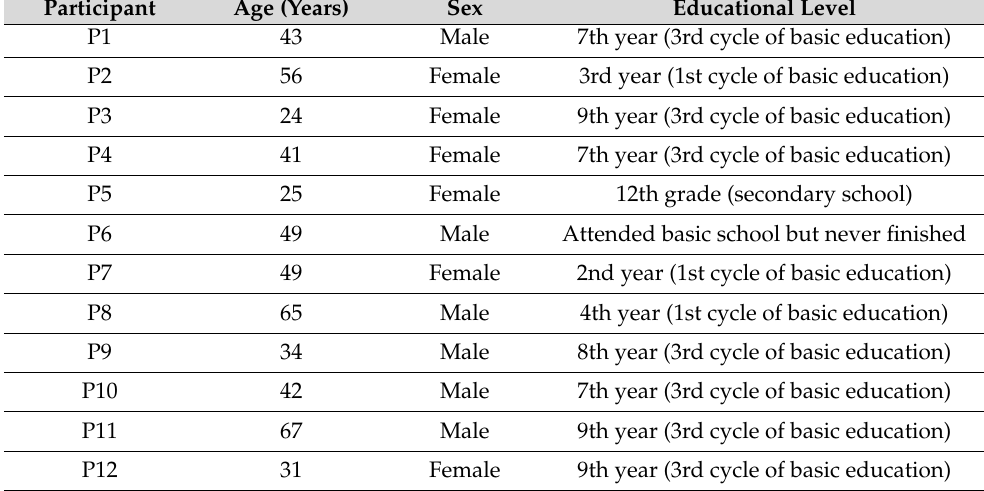
Table 1. Participants’